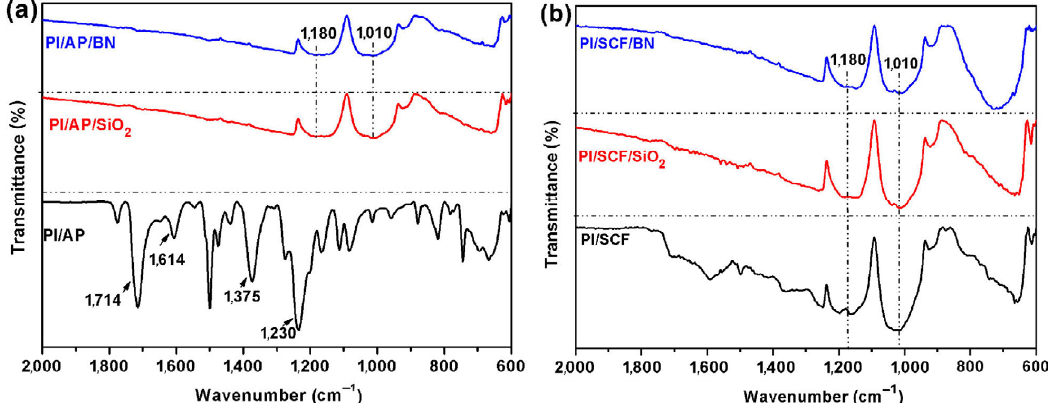
Fig. 16 ATR-FTIR spectra of tribofilms formed on Al 2 O 3 surface when sliding against (a) AP-reinforced PI composites and (b) SCF- reinforced PI composites at 8